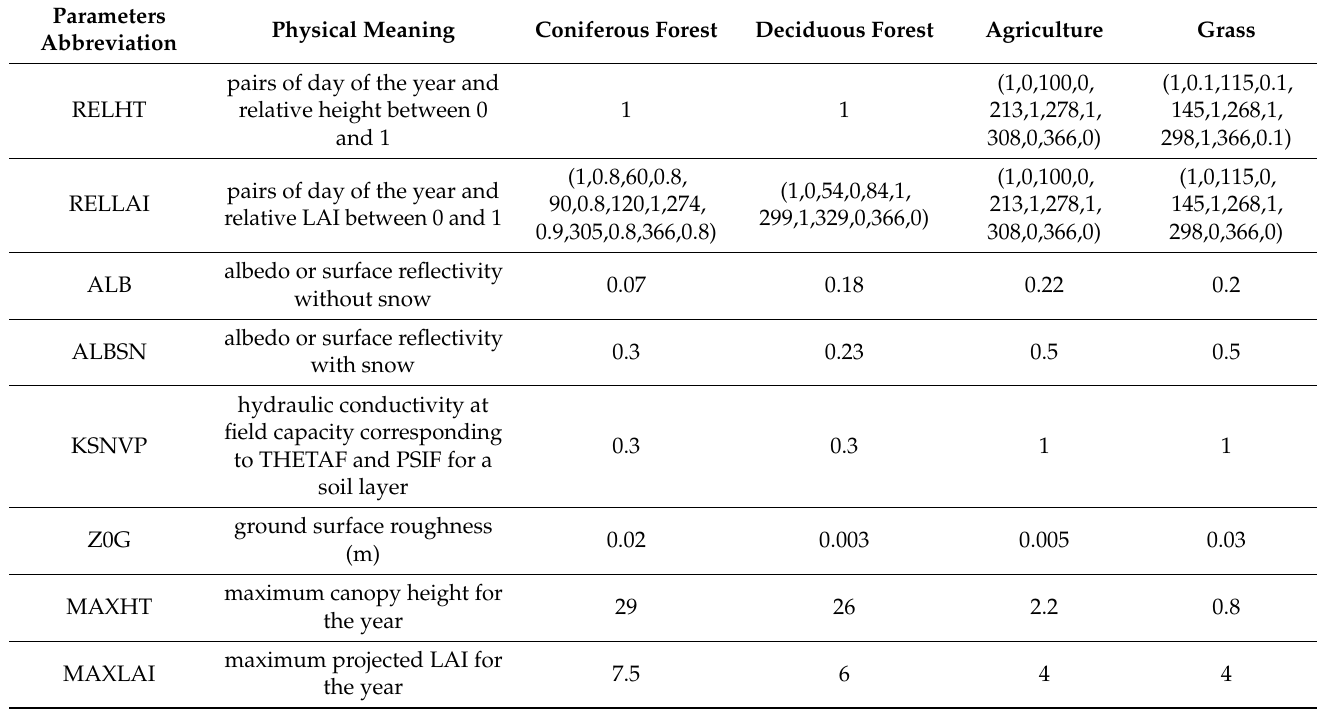
Table A1. Physical meanings and values of main parameters of the BROOK90 model for different vegetation at the study